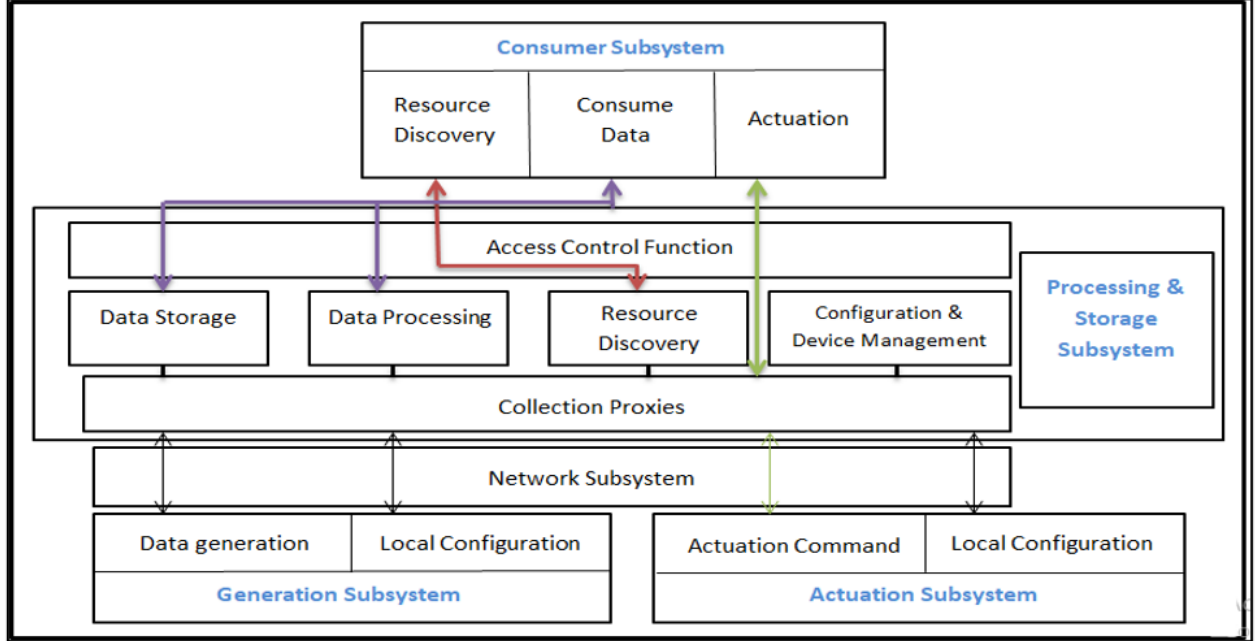
Figure 1. Functional IOT architecture for personalized healthcare.